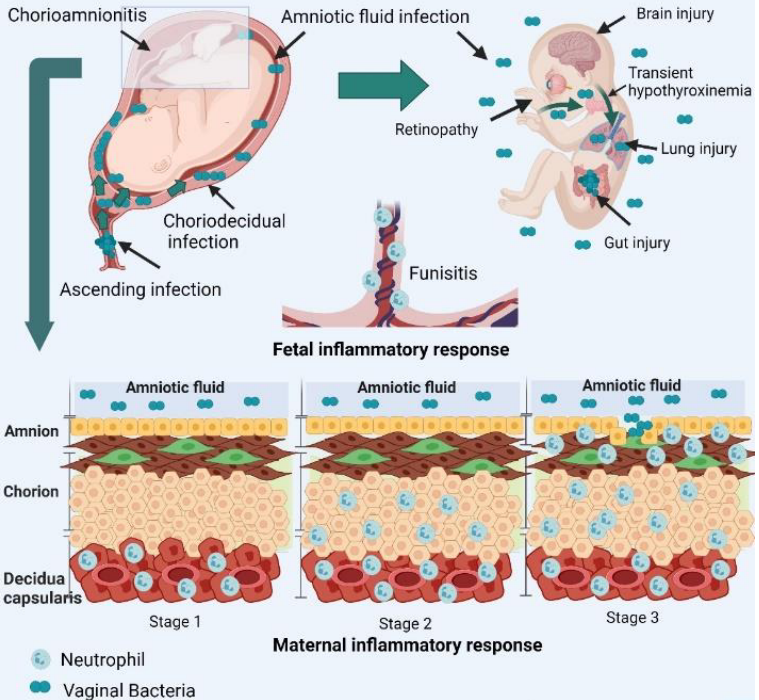
Figure 1. Physiopathology of CA at the maternal and fetal sides. Maternal inflammatory response is defined as stage 1 in case of acute subchorionitis or chorionitis, stage 2 in case of acute CA: poly- morphonuclear leukocytes extend into fibrous chorion or, amnion and stage 3 in case of necrotizing CA: karyorrhexis of polymorphonuclear leukocytes, amniocyte necrosis, and/or amnion basement membrane hypereosinophilia. Fetal inflammatory response is defined as stage 1 in the case of chori- onic vasculitis or umbilical phlebitis, stage 2 in case of involvement of the umbilical vein and one or more umbilical arteries, and stage 3 in case of necrotizing funisitis [1]. (Created with BioRender.com 23 March